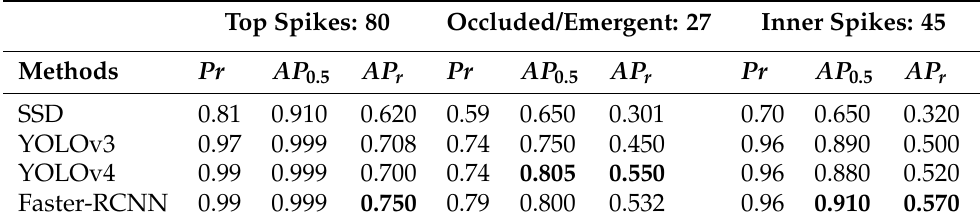
Table 5. Summary of detection model evaluation on matured top/inner vs. occluded/emergent spikes. Inner spikes include also occluded spikes. Probability, Pr is shown in the first column. AP 0.5 and AP r : AP 0.5:0.95 are PASCAL VOC and COCO evaluation measures, respectively. The numbers of the top, occluded and inner spikes are 80, 27 and 45. The best results are highlighted in bold. Top Spikes: 80 Occluded/Emergent: 27 Inner Spikes: 45